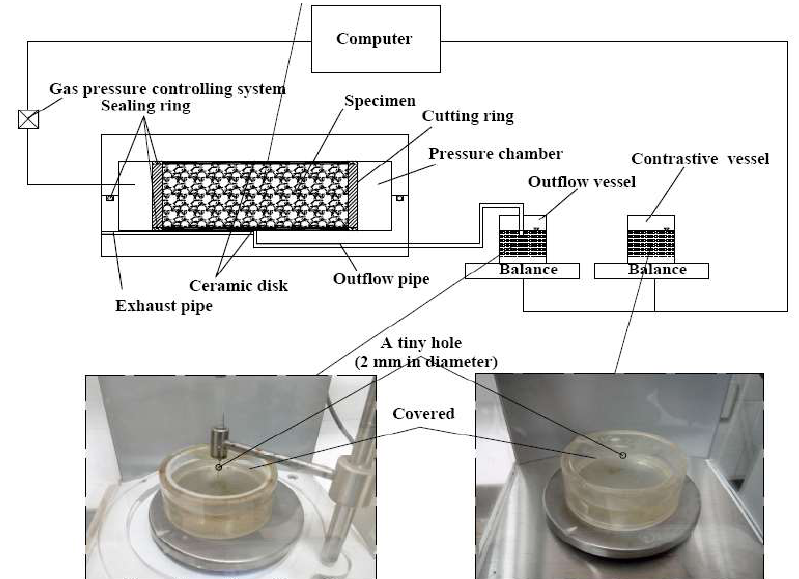
Figure 1. Schematic diagram of the instrument.